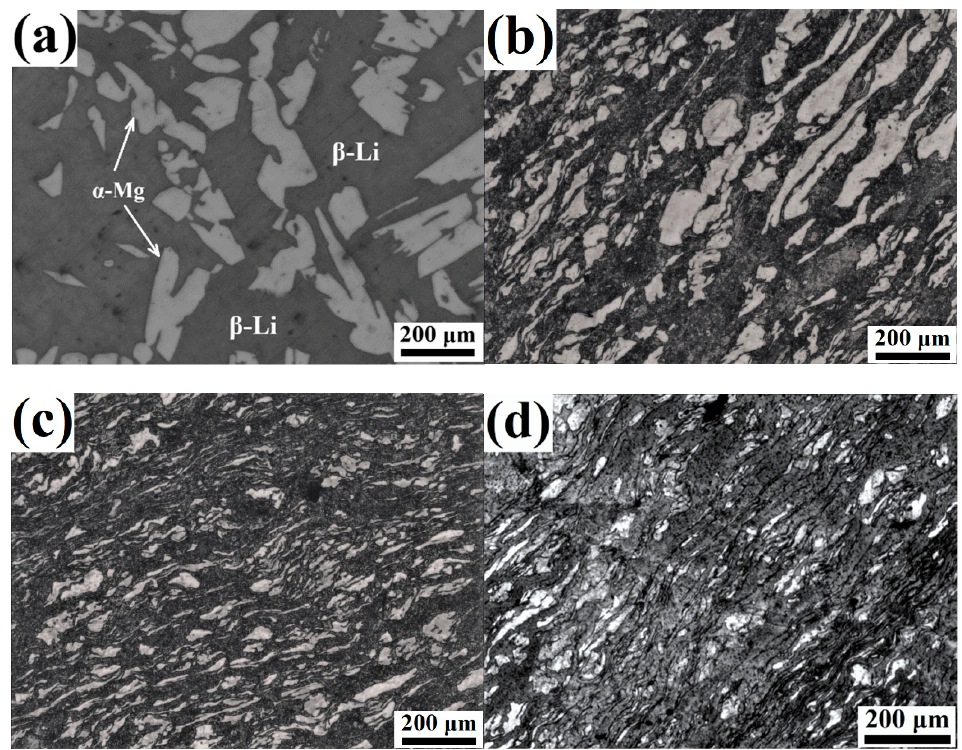
Figure 2. Optical Micrographs of as-cast and equal-channel-angular-pressing (ECAP)ed Mg-9Li alloys: ( a ) cast; ( b ) E4; ( c ) E8; ( d ) E16.